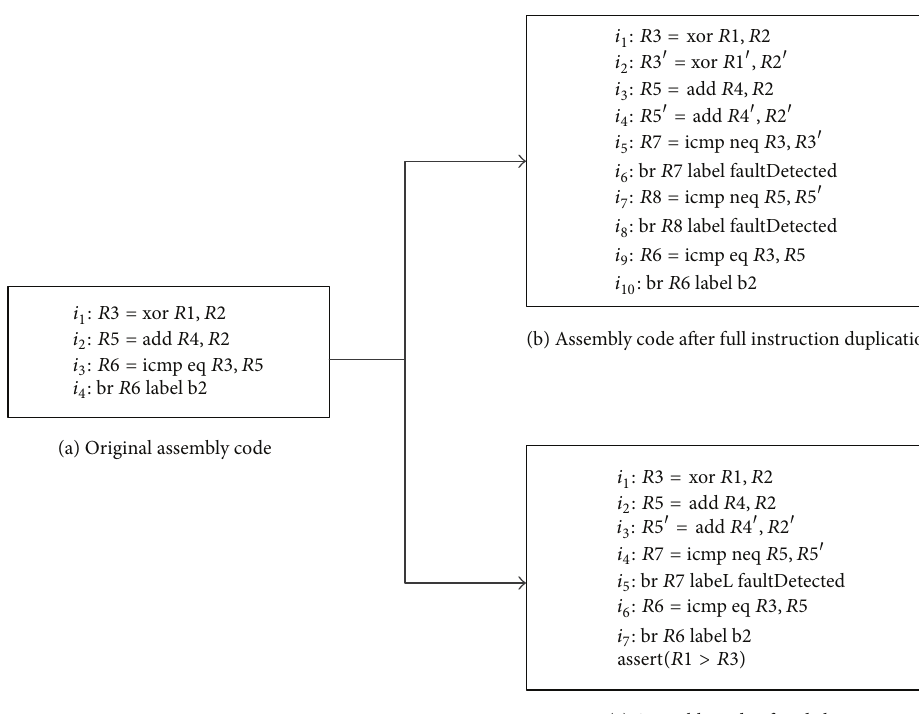
Figure 3: A sample assembly code before and after transformation of full instruction duplication and Radish D.